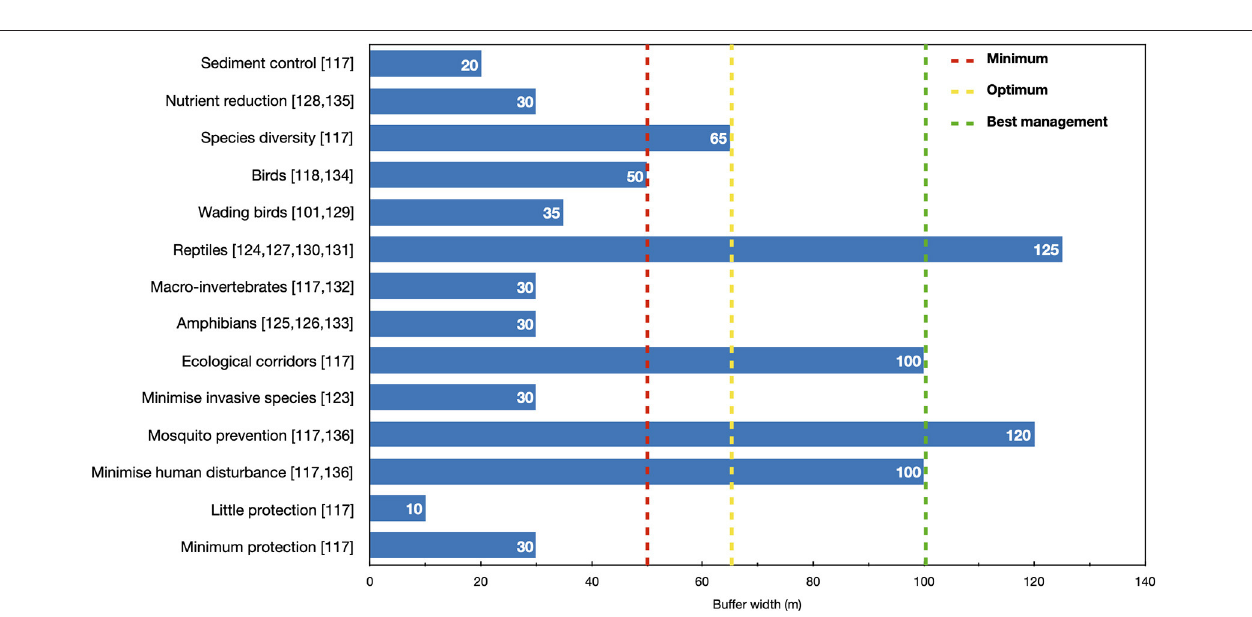
FIGURE 5 | Conceptual overview of the regulation and impacts of the wetland system. Regulation of activities: (a) water authority, (b) planning council, (c) municipal, state, and national department of conservation. Impact on physical wetland system (red: negative impact; green: positive impact): (1) dehydration, (2) disturbance, (3) fragmentation, (4) eutrophication, (5) nature restoration.